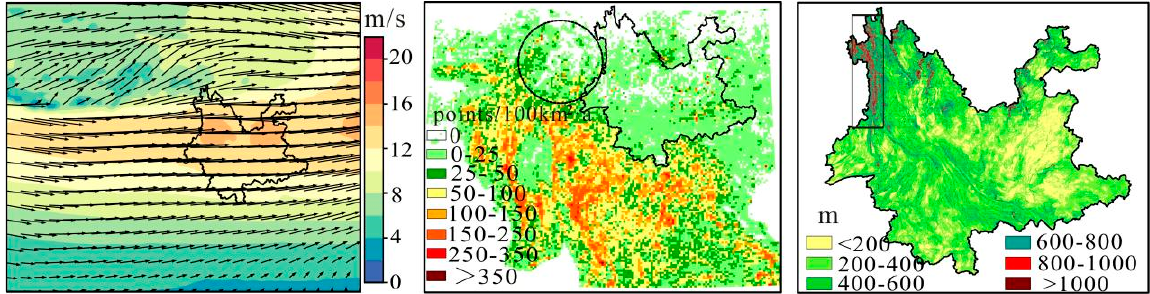
Figure 5. For the majority of Southeast Asia (90° to 107° E, 15° to 29° N), Yunnan Province’s topographic relief and average annual biomass combustion fire points are distributed spatially from 2015 to 2020.